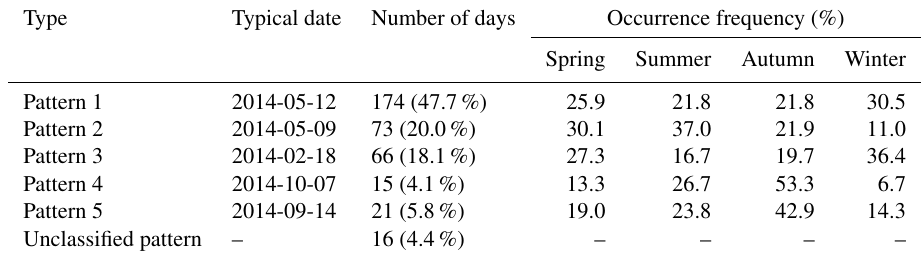
Table 3. The typical date, number of days, and seasonal occurrence frequencies of each synoptic weather pattern. Type